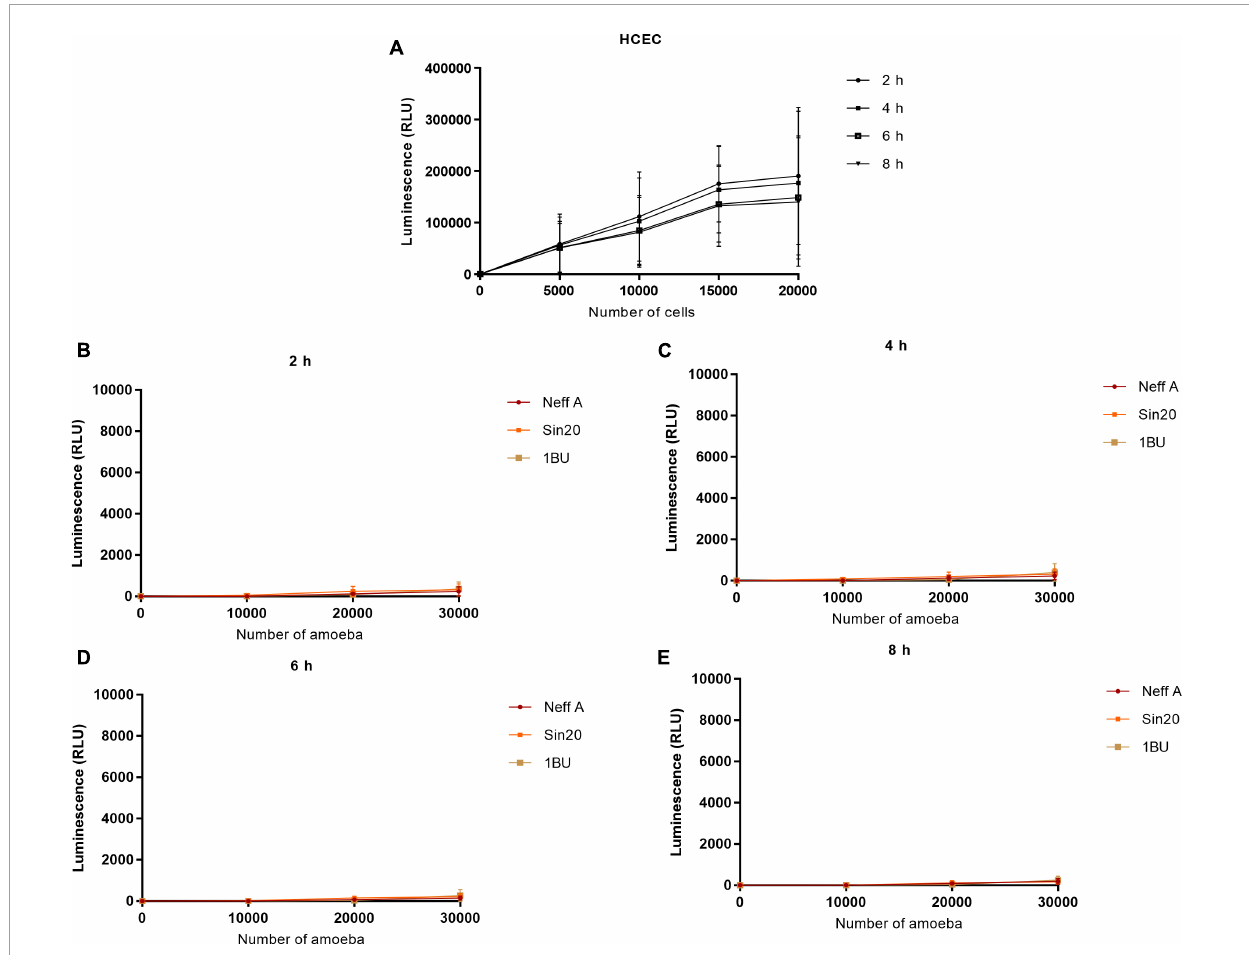
FIGURE4 Effect of HCEC (A) and amoeba (B–E) densities on the luminescence signal by using the RealTime-Glo TM MT Cell Viability assay. The background absorbance obtained with the media alone without cells was subtracted from all